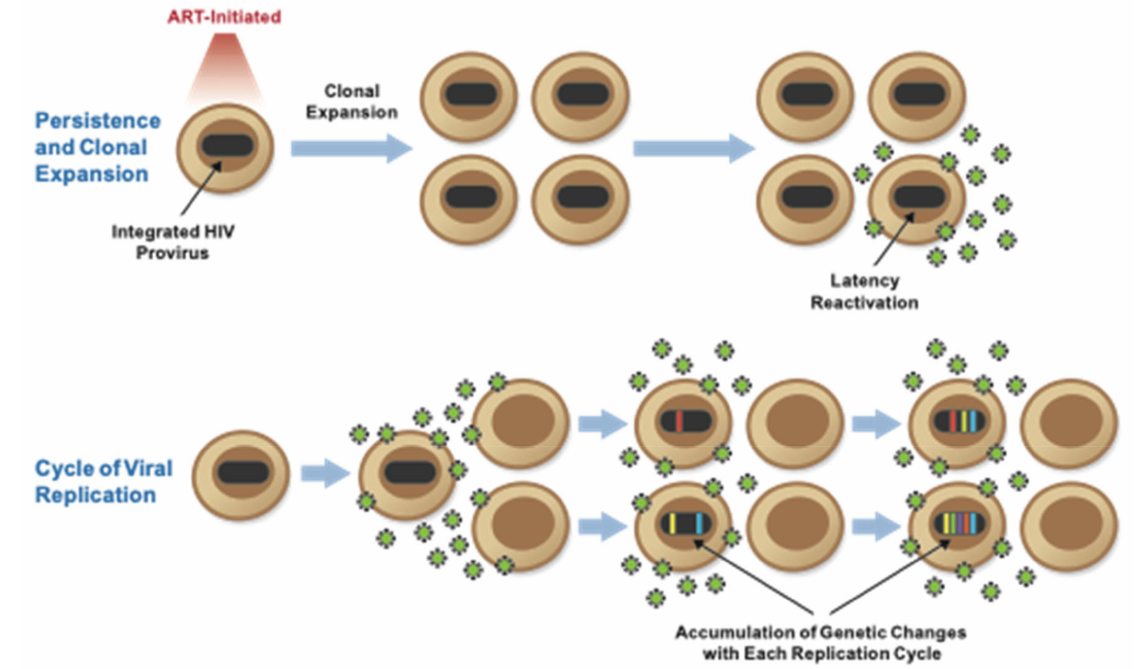
Figure 3. Clonal expansion vs. viral replication. HIV infection may persist via multiple mechanisms. Without ART, or with inadequate ART, cycles of active viral replication continue, leading to the infection of new susceptible cells. New cycles of infection result in new mutations and genetic variation. Even while on effective ART, HIV proviruses persist via the clonal expansion of HIV-infected cells. Clonally expanded cells may be replication-competent, periodically reactivate from a latent state, and may produce infectious virus, leading to low-level viremia. With effective ART, this low-level viral production is unlikely to infect new cells. Adapted from